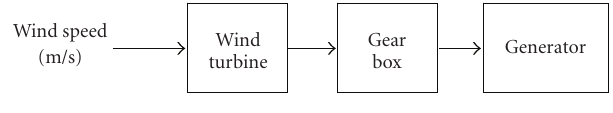
Figure 1: Wind turbine system.